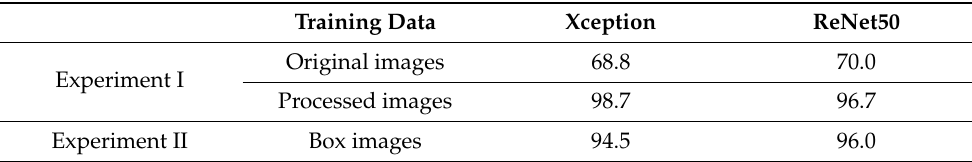
Figure 8. Results of Experiment II: ( a ) train and test with box images using Xception; ( b ) train and test with box images using ResNet50. Table 3. Test accuracy (%) of Experiments I & II with ResNet50 and Xception.